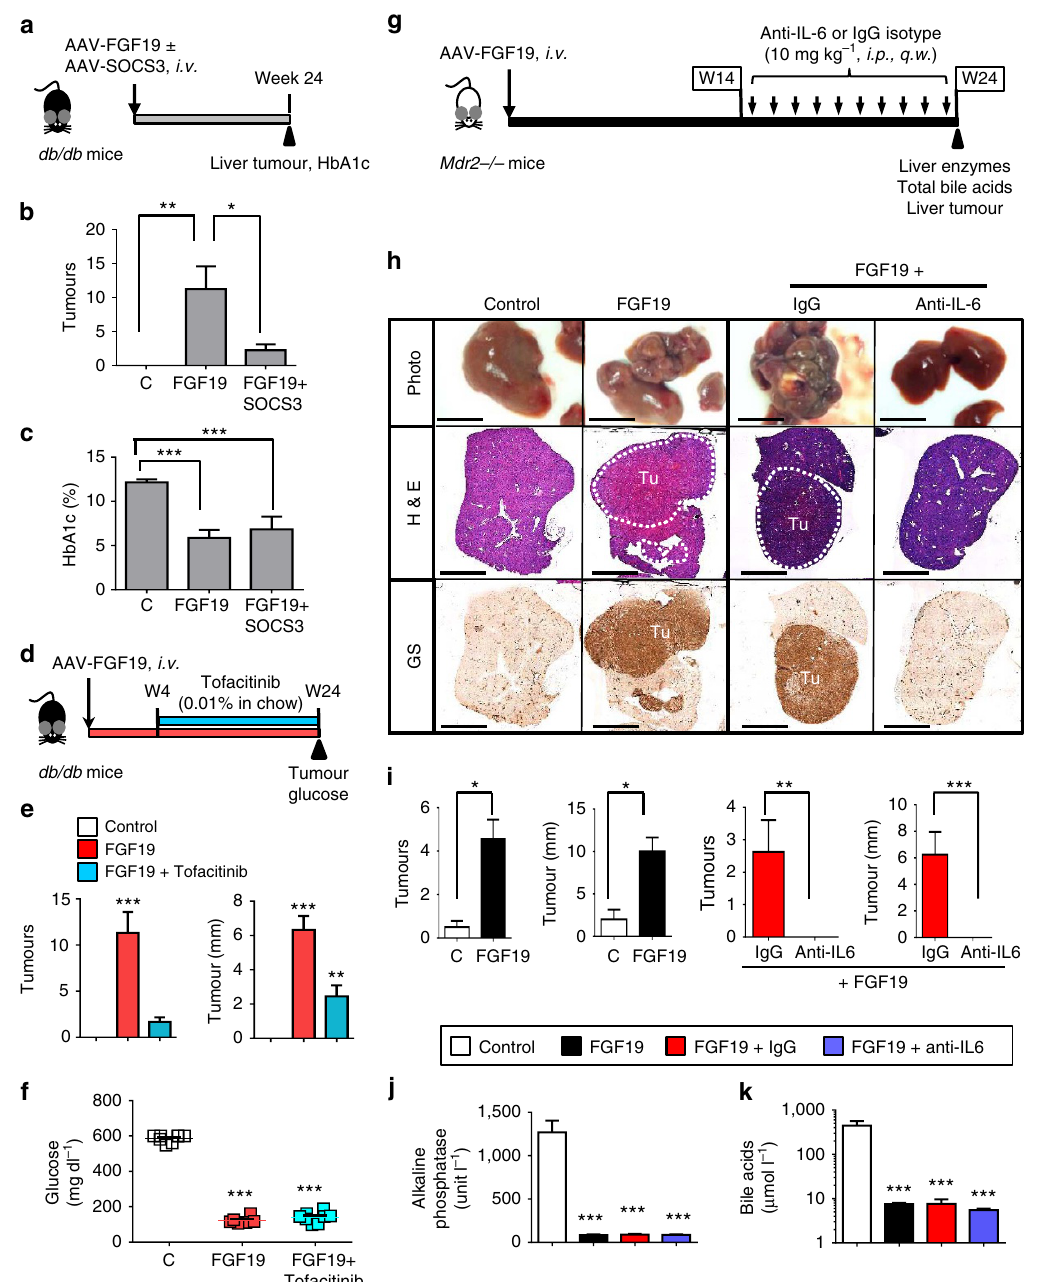
Figure 7 | Pharmacological inhibition of the STAT3/IL-6 axis abolishes FGF19-dependent HCC. ( a ) Schematic diagram for AAV-SOCS3 study in db/db mice. 11 B 12 week old db/db mice were i.v. administered with AAV- FGF19 with or without AAV-SOCS3, or a control (C) virus ( n ¼ 5 per group). Mice were killed 24 weeks later for liver tumour analysis. ( b ) SOCS3 inhibits FGF19-induced liver tumour formation. ( c ) FGF19 normalizes HbA1c in db/db mice in the absence or presence of SOCS3. ( d ) Schematic diagram for tofacitinib study in db/db mice. 11 B 12-week old db/db mice were i.v. administered with AAV- FGF19 or a control virus ( n ¼ 5 per group). Tofacitinib treatment was initiated 4 weeks later. Mice were killed 24 weeks after AAV injection. ( e ) Tofacitinib inhibits FGF19-induced liver tumour formation. ( f ) FGF19 normalizes blood glucose levels in db/db mice irrespective of tofacitinib treatment. Dots in scatterplot represent individual animals. ( g ) Schematic diagram for anti-IL-6 study in Mdr2 (cid:3) / (cid:3) mice. Mdr2 (cid:3) / (cid:3) mice received a single tail vein injection of AAV- FGF19 . Starting from week 14 after AAV injection, mice were dosed intraperitoneally ( i.p .) with 10mgkg (cid:3) 1 anti-mouse IL-6 ( n ¼ 10) or an isotype control antibody ( n ¼ 8) weekly ( q.w .). Tumours were analysed 24 weeks after AAV administration. ( h ) Representative liver images and histological liver sections stained with H&E or anti-glutamine synthetase (brown). Tu, tumours. Scale bars, 5mm. ( i ) Tumour multiplicity and tumour size. ( j ) Serum levels of alkaline phosphatase at the end of the study. ( k ) Serum levels of total bile acids. Values are mean ± s.e.m. *** P o 0.001, ** P o 0.01, * P o 0.05 by unpaired two-tailed t -test when comparing two groups, or versus control group by one-way ANOVA when comparing multiple